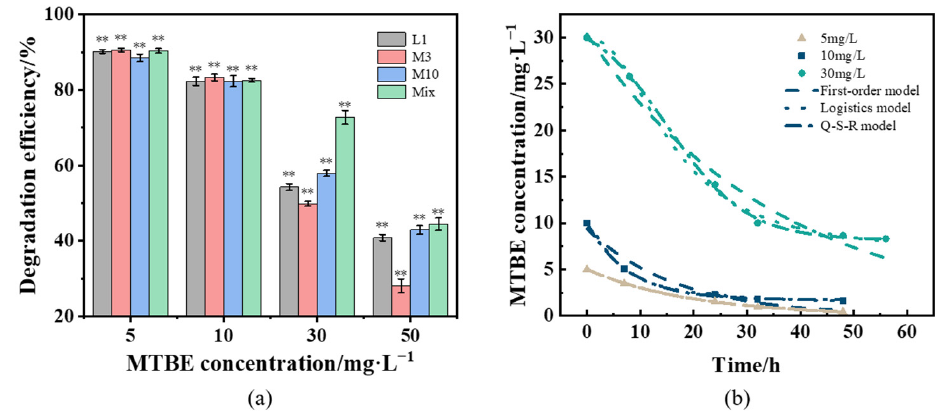
Figure 2. The comparison of the degrading capacity of pure strains and their mixture under different concentrations. ( a ) The efficiency of MTBE degradation by pure strains and their mixture. ( b ) Time course for MTBE degradation by mixed consortium and simulation results for three models. Symbols present the experimental data and curves show their statistic tendencies. ** represents p < 0.01.